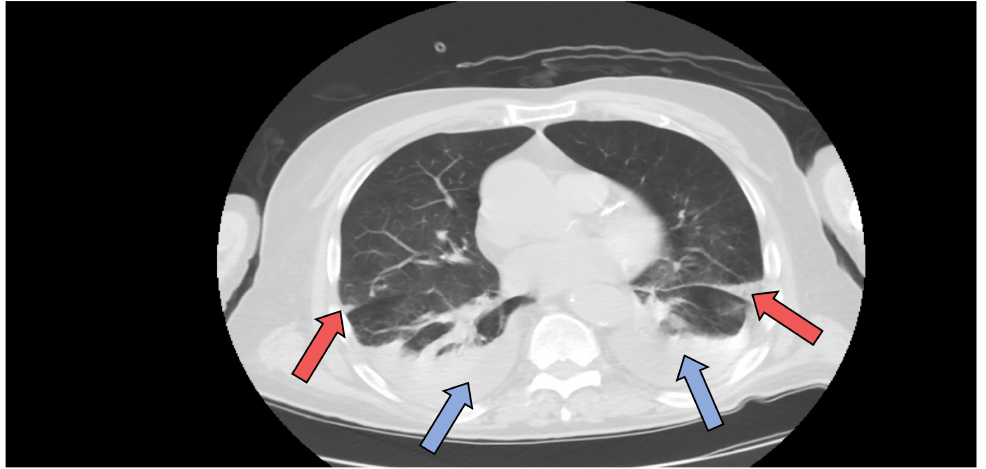
Figure 3. Chest computer tomography (CT) axial view showing bilateral pulmonary infarction (red arrows) and bilateral pleural effusion (blue